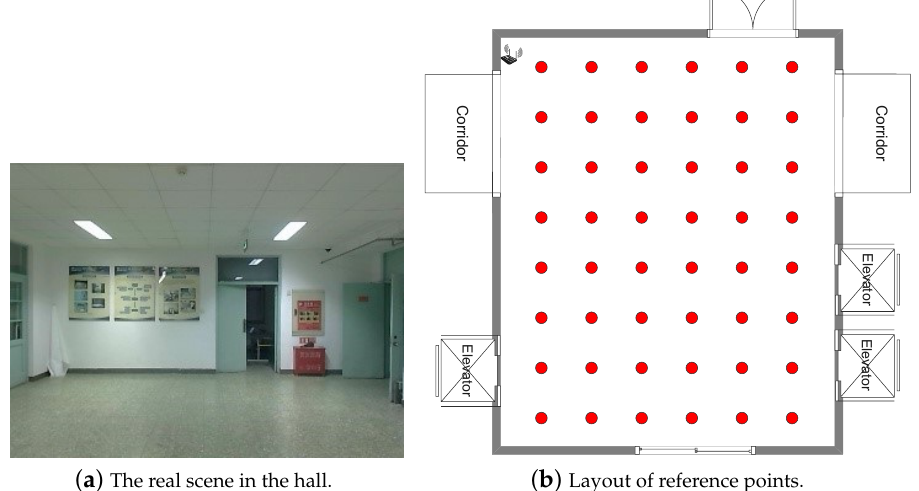
Figure 9. The diagram of the hall